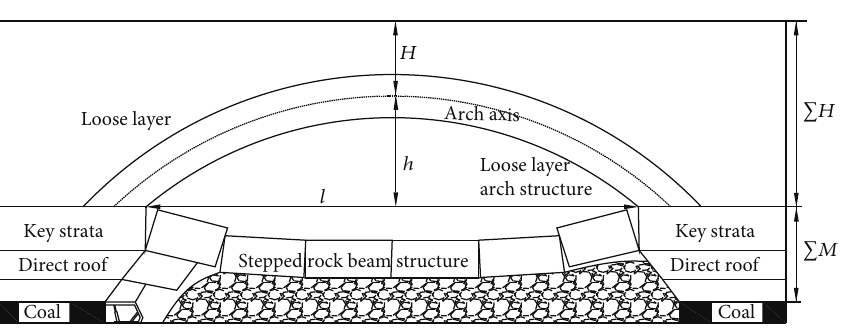
Figure 3: Research fl ow chart.